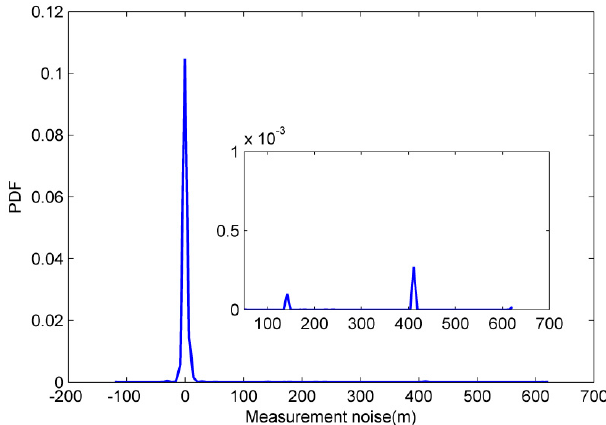
Figure 5. Probability density function (PDF) of measurement noise.